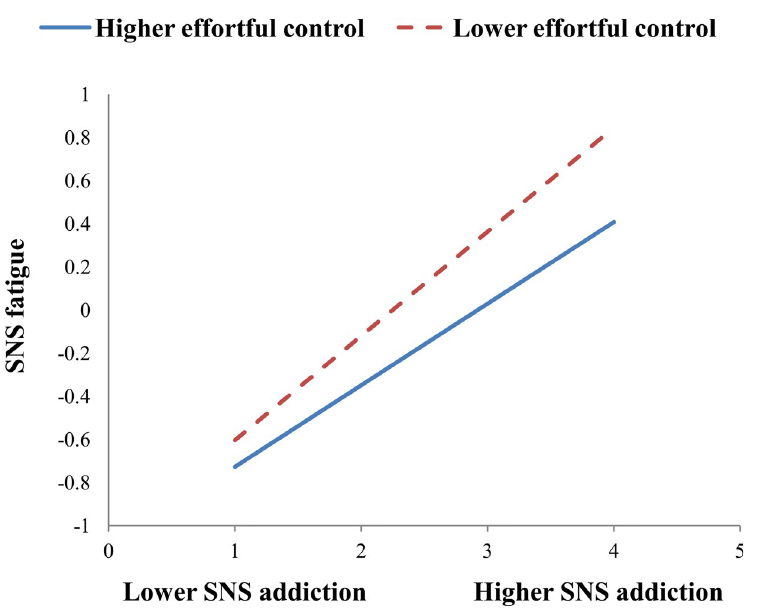
Fig 2. Effortful control moderates the relation between SNS addiction and SNS